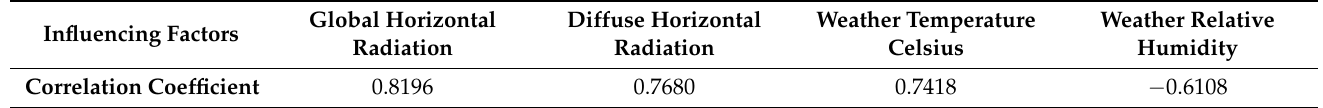
Table 2. SCC results between the PV power and other influencing